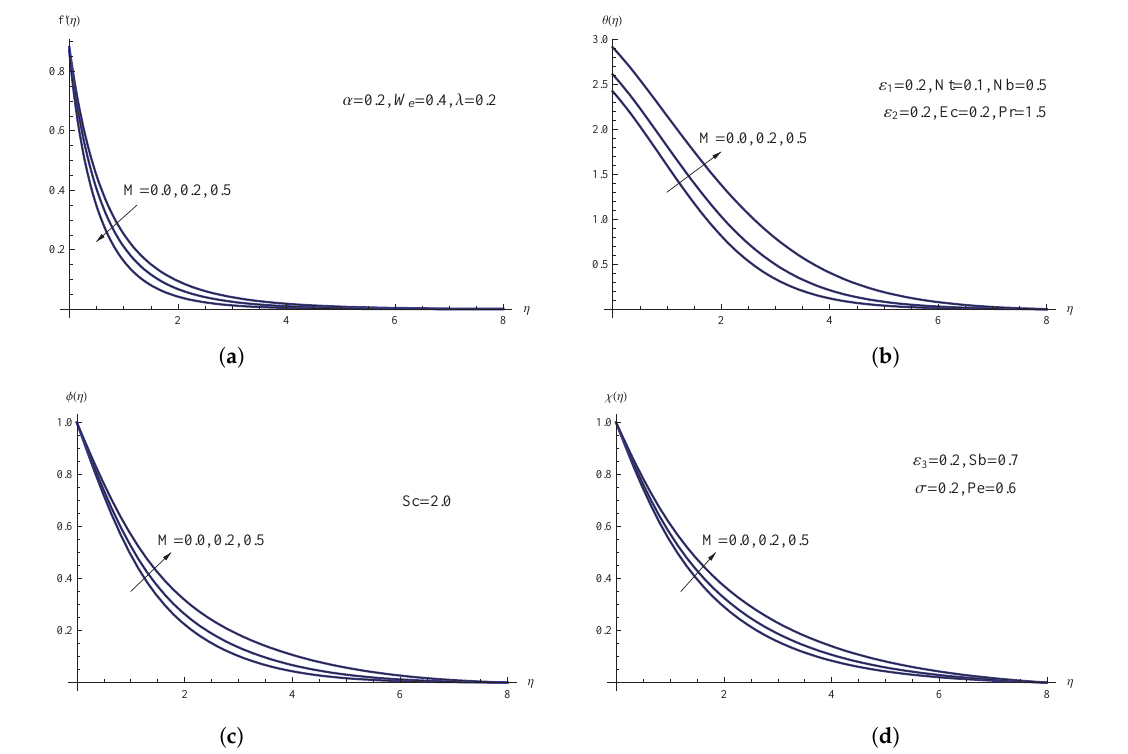
Figure 2. ( a ) f (cid:48) ( η ) for various M . ( b ) θ ( η ) for various M . ( c ) φ ( η ) for various M . ( d ) χ ( η ) for various M